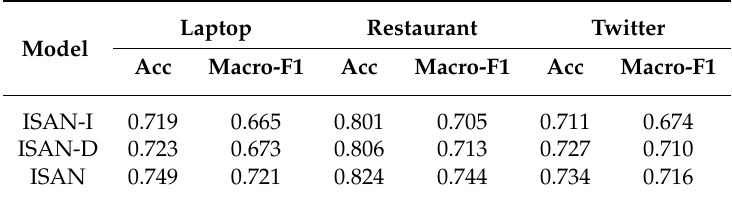
Table 3. Performance comparison of ISAN models on the three datasets.